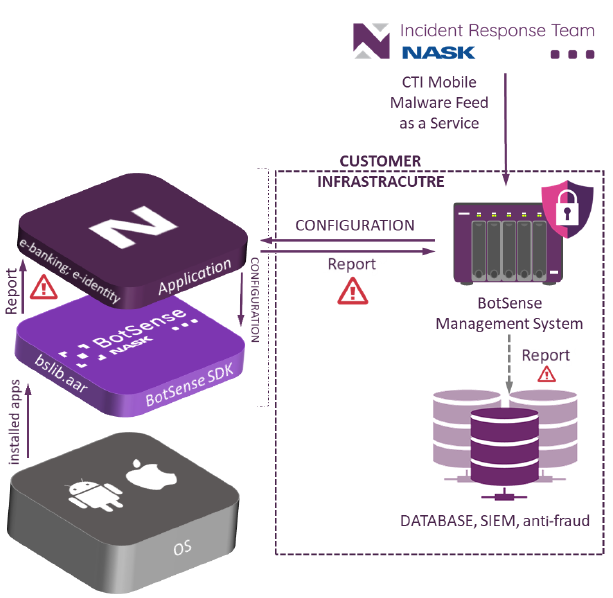
Figure 1. BotSense mobile deployment